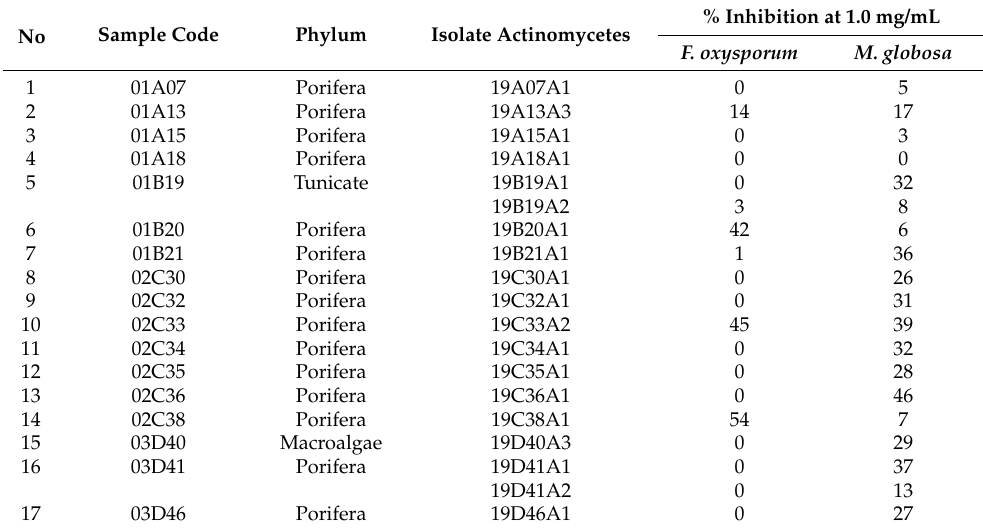
Table 1. Screening of antifungal